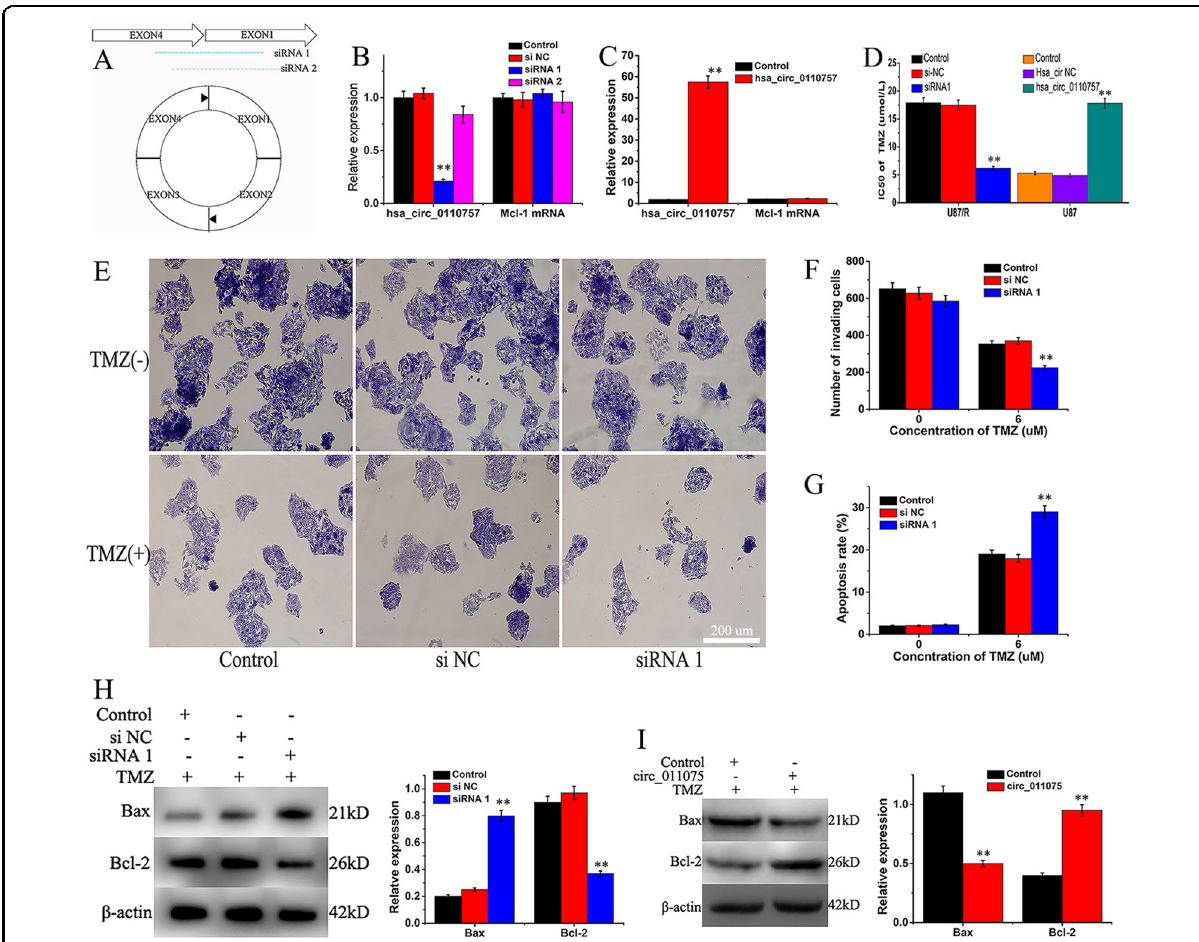
Fig. 2 Hsa_circ_0110757 promotes TMZ resistance of glioma cell in vitro. A The siRNA targeting the back-splice junction (siRNA 1 and siRNA 2). B The expression of hsa_circ_0110757 and Mcl-1 mRNA in U87/R cells with or without siRNA by RT-PCR. C The expression of hsa_circ_0110757 and Mcl-1 mRNA in U87 cells with or without stable transfection of hsa_circ_0110757 by RT-PCR. U87 cells without any transfection were set as control group. D The IC50 of TMZ in U87/R cells with transfection of si-hsa_circ_0110757 and U87 cells with transfection of hsa_circ_0110757 for 48 h. E , F The invasion ability of the U87/R cells. G The apoptotic rates of U87/R cells with or without siRNA 1 in the absence or presence of TMZ. H The expression of Bax and Bcl-2 in U87/R cells with or without siRNA 1 in the presence of TMZ for 24 h. I The expression of Bax and Bcl-2 in U87/R cells with or without hsa_circ_0110757 in the presence of TMZ for 24 h. * P < 0.05, ** P < 0.01, *** P <